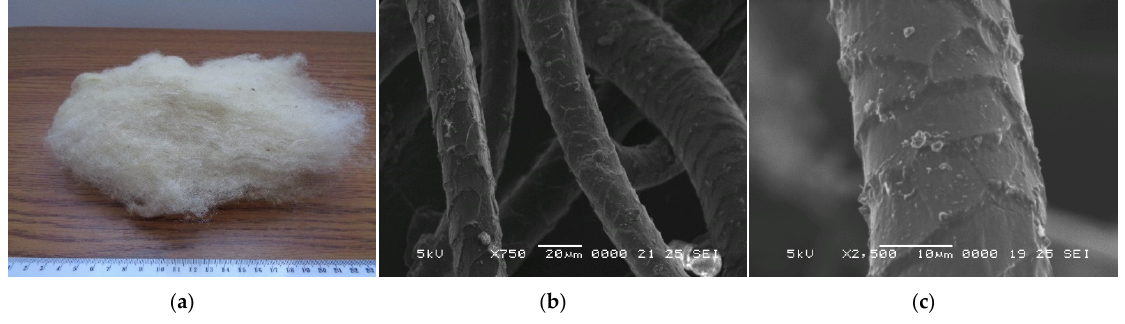
Figure 1. Fibres used for the wool-based composite panels: ( a ) overall aspect of wool fibres; SEM images with a magnification of ( b ) ×750 and ( c ) ×2500.